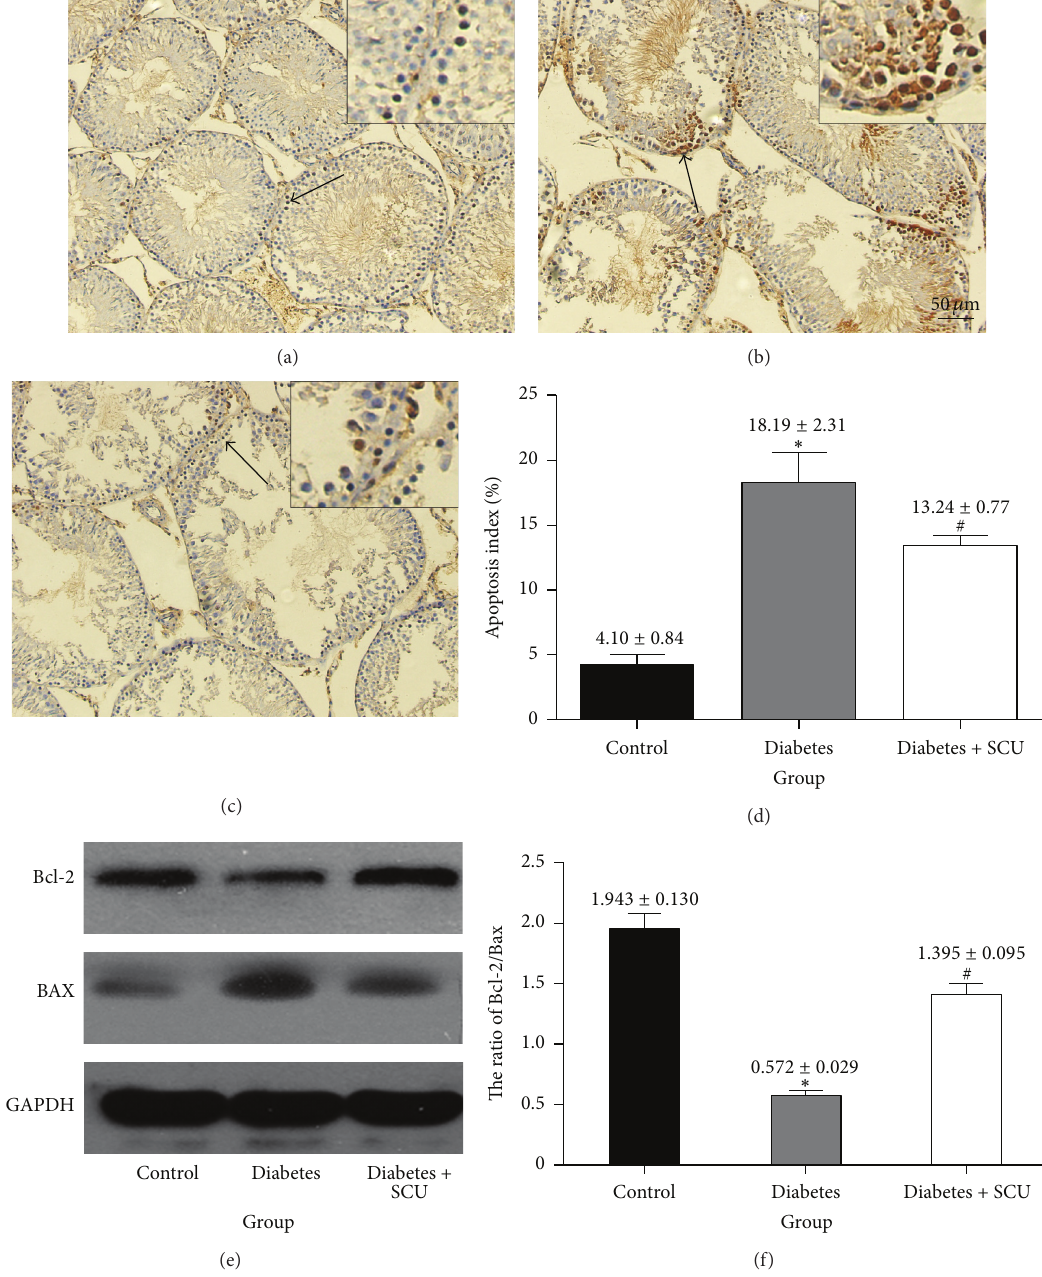
Figure 3: Diabetes induces ROS production and lipid peroxidation with enhanced cellular apoptosis. (a)–(d) TUNEL staining of testes sections from control, diabetes, and diabetes + SCU rats. TUNEL-positive cells (indicated by arrows) in representative images are shown in (a), (b), and (c) (200x magnification and 400x magnification). Hoechst was used as cell nucleus staining. The % of apoptotic cells were quantified in (d) and calculated following the formula Apoptosis index = apoptotic cells/(apoptotic cells + normal cells) (d). Data in (d) are presented as means ± SEM, 3 fields per section and 5 sections from each testis. 𝑛 = 8 rat for each group, and analyzed by 𝑡 -test. ∗ Significantly different from control group ( 𝑃 ≤ 0.05 ); # significantly different from diabetes group ( 𝑃 ≤ 0.05 ). (e) Western blot analysis was used to determine the protein expression of Bcl-2 and Bax in testicular tissue. GAPDH was used as loading control. (f) The ratio of Bcl-2/Bax was determined by quantitative evaluation of the protein expression of Bcl-2 and Bax using densitometry analyses. Samples were from three individuals in each group. Data in (f) are presented as mean ± SEM. ∗ Significantly different from control group ( 𝑃 ≤ 0.05 ); # significantly different from diabetes group ( 𝑃 ≤ 0.05